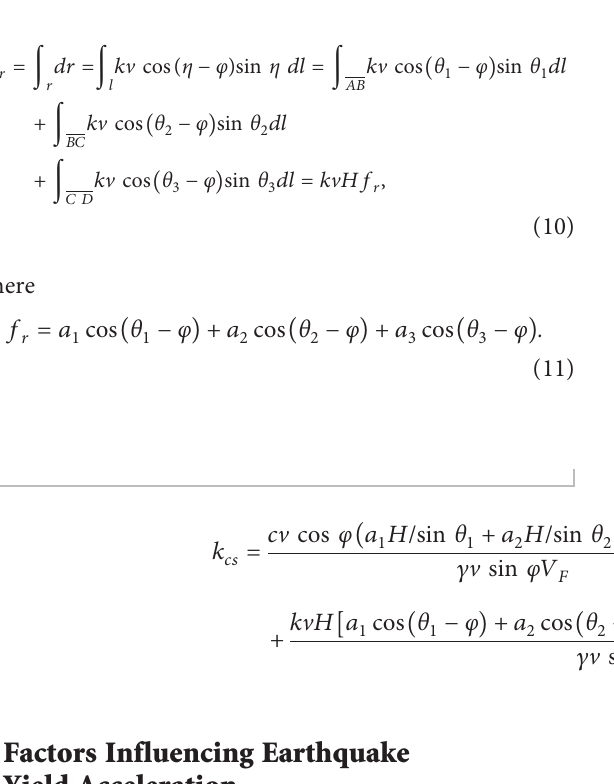
Figure 14: Plots of λ values for the simplified model with respect to the predicted fracture